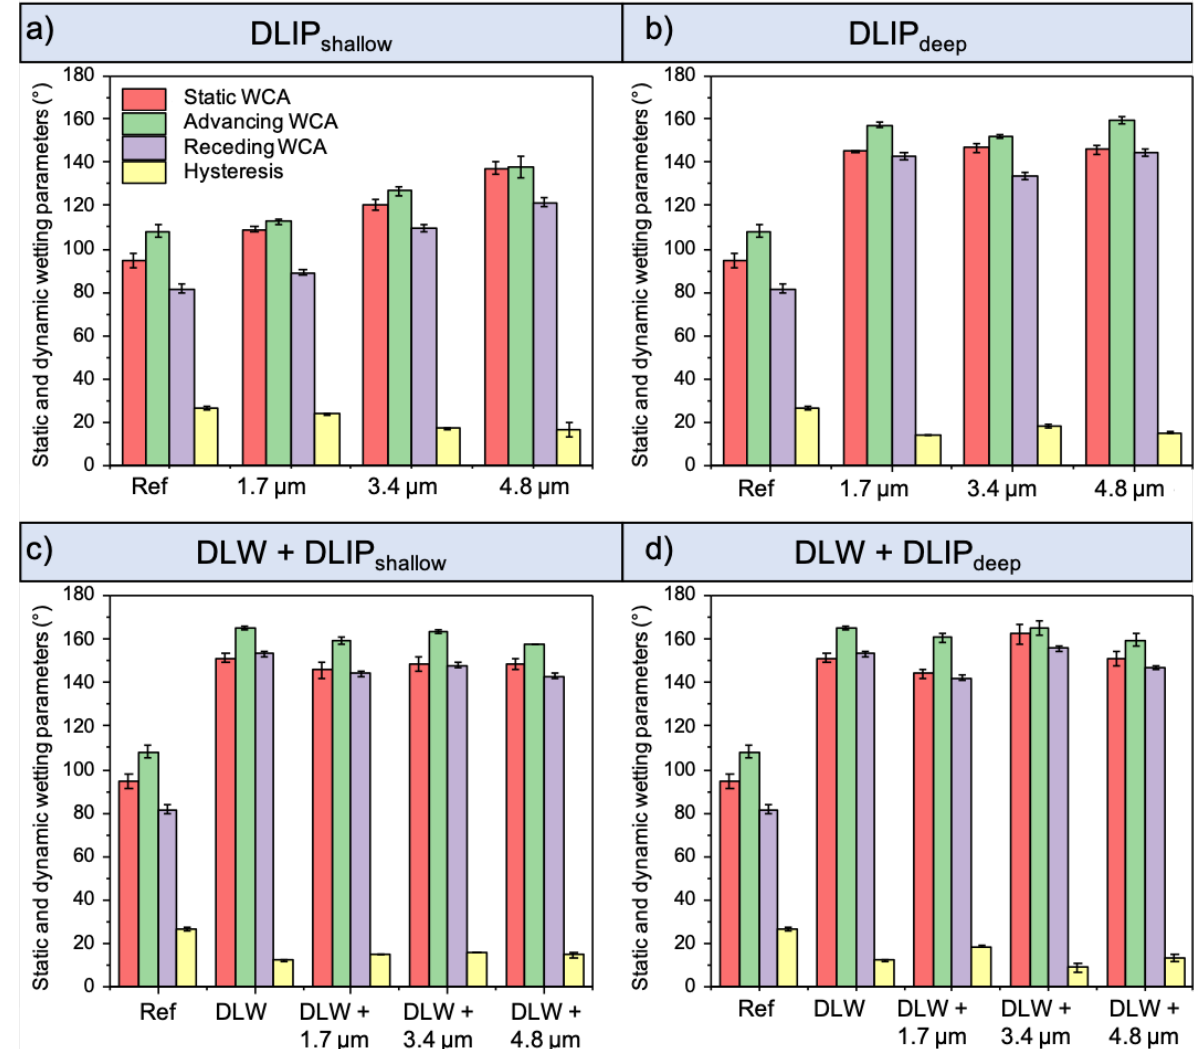
Figure 6. Static, advancing and receding water contact angles as well as the WCA hysteresis of the fabricated single-scale shallow ( a ) and deep ( b ) DLIP textures and of the multi-scale textures including shallow ( c ) and deep ( d ) DLIP elements measured 80 days after laser processing.